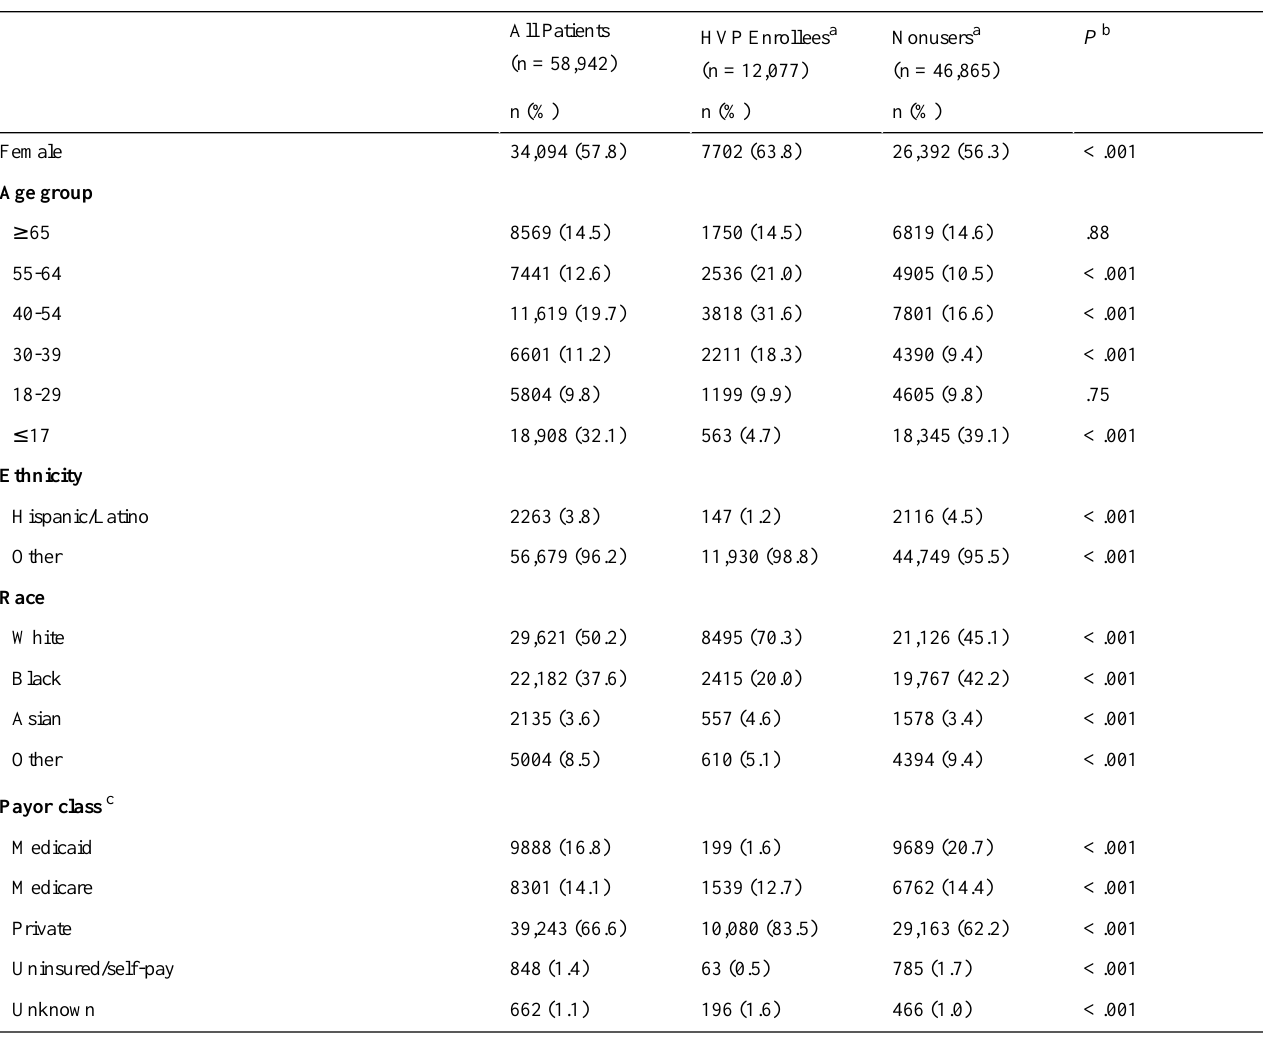
Table 1. Demographic characteristics of patients seen at seven Duke Medicine clinics during